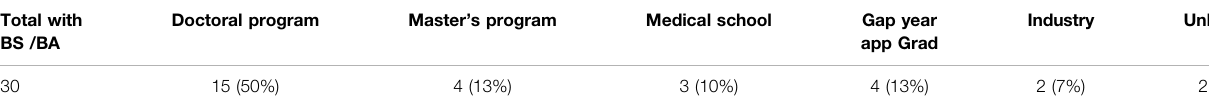
TABLE 2 | Academic/ professional status of Choose Development! fellows with Bachelor ’ s degree. Total with Doctoral program BS /BA